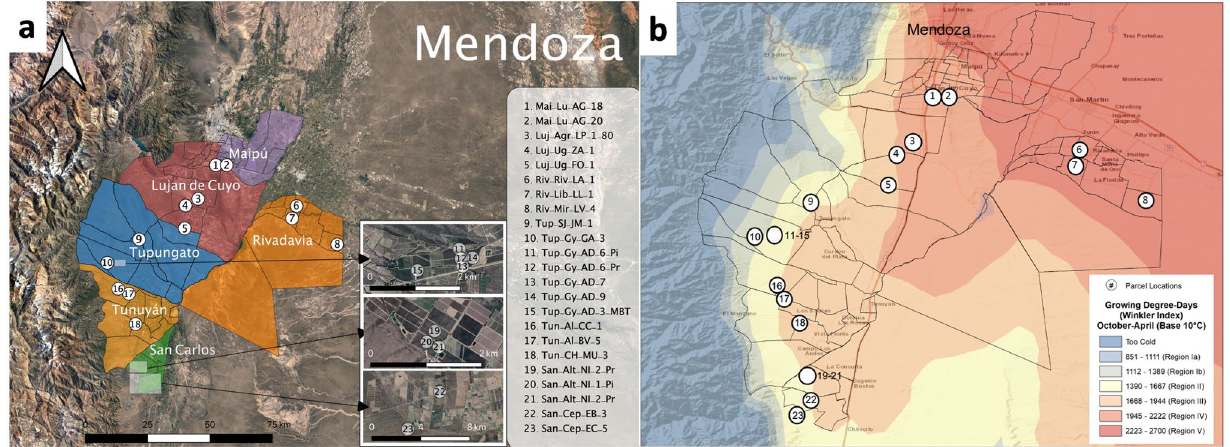
Figure 1. ( a ) Distribution of parcels in 12 GIs belonging to six Departments of the three main viticulture zones, First Zone, East Zone and Uco Valley. ( b ) Average growing degree-days (GDD), over Mendoza derived from TerraClimate 1958–2019 with a monthly temporal resolution and a ~ 4-km (1/24th degree) spatial resolution 14 . GDD class limits originally given by Amerine and Winkler 15 along with lower and upper bounds for Region I and Region V (see text). The images were created PowerPoint, QGIS.org, 2021. QGIS Geographic Information System. QGIS Association. http://www.qgis.org and ArcGIS 10.8;